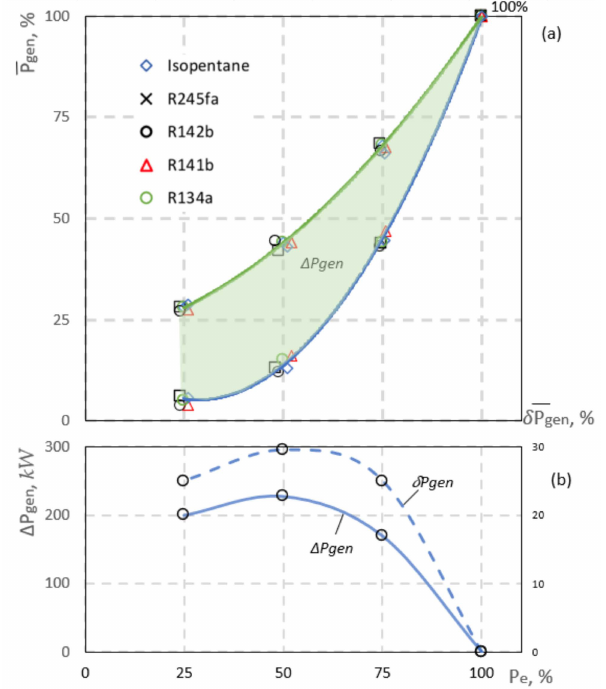
Figure 6. ( a ) P gen generated mechanical power in load cycle with ORC realization; blue line = π T = variable ; green line = π T = const. ; ( b ) turbine construction impact to P gen for comparative